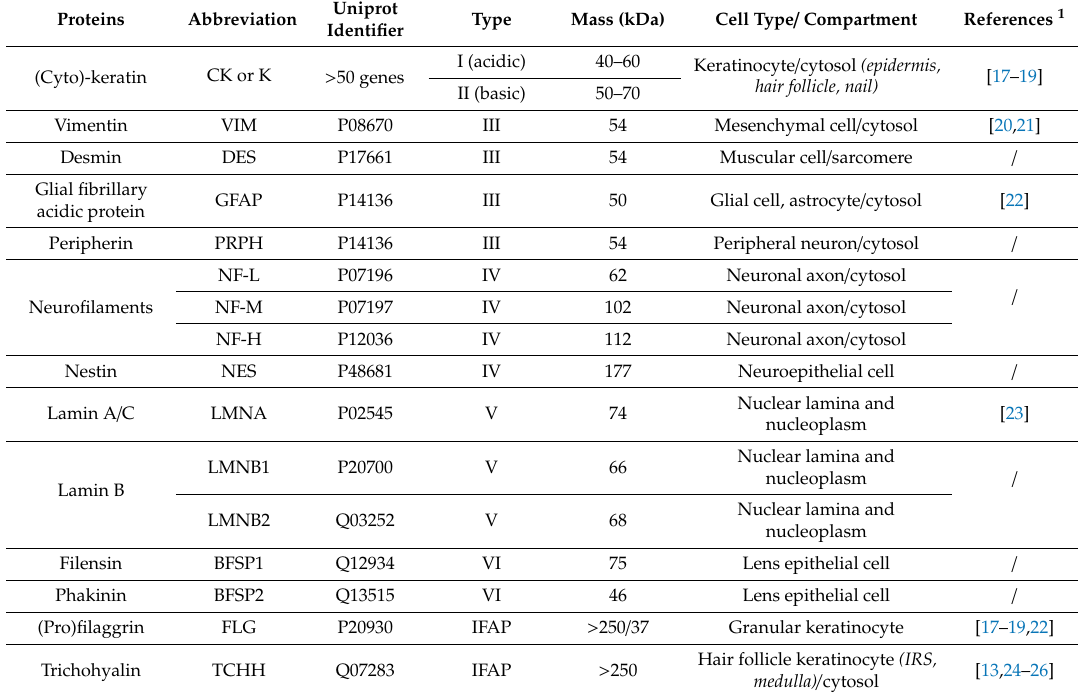
Table 1. Classification of intermediate filament proteins and some intermediate filament associated proteins